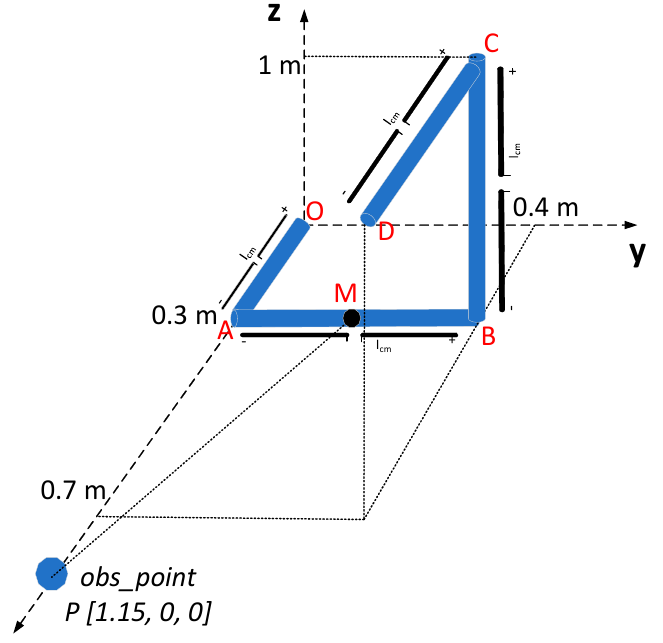
Figure 1. Application of the near-field dipole segmentation technique in a complex cable geome- try.